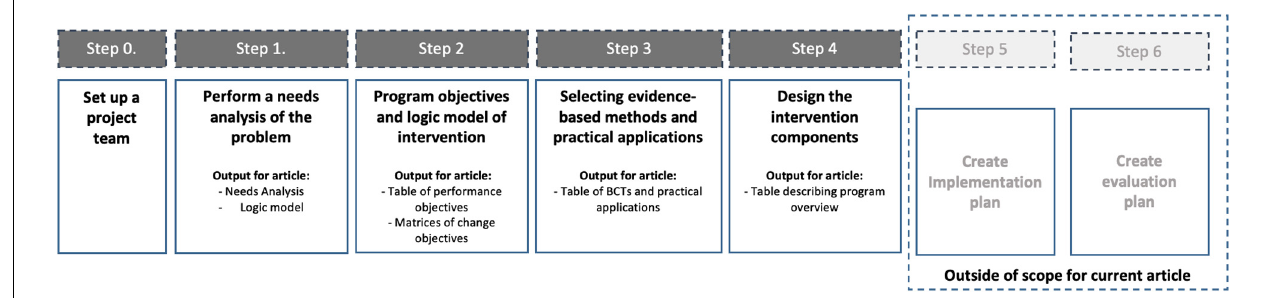
FIGURE 1 | Visualisation of the Intervention Mapping process and the outputs at each of the steps covered in the intervention development